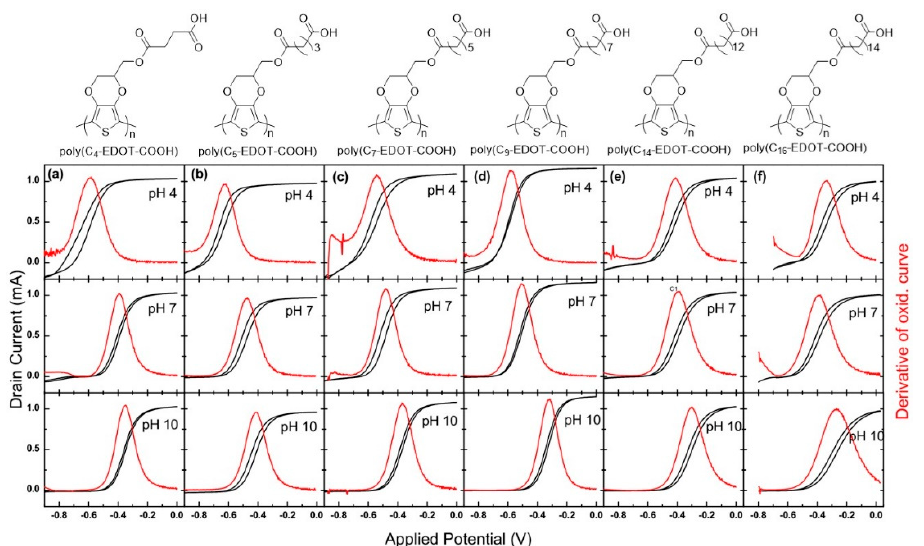
Figure 2. Drain current measurement of ( a ) poly(C 4 -EDOT-COOH); ( b ) poly(C 5 -EDOT-COOH); ( c ) poly(C 7 -EDOT-COOH); ( d ) poly(C 9 -EDOT-COOH); ( e ) poly(C 14 -EDOT-COOH); and ( f ) poly(C 16 -EDOT-COOH) electrodeposited on 10 µm IMEs in 10 mM of pH 4, pH 7 and pH 10 buffer solutions using 0.1 M of KNO 3 as supporting electrolyte. The red line indicates the first derivative of the oxidation drain current sweep ( E onset ).